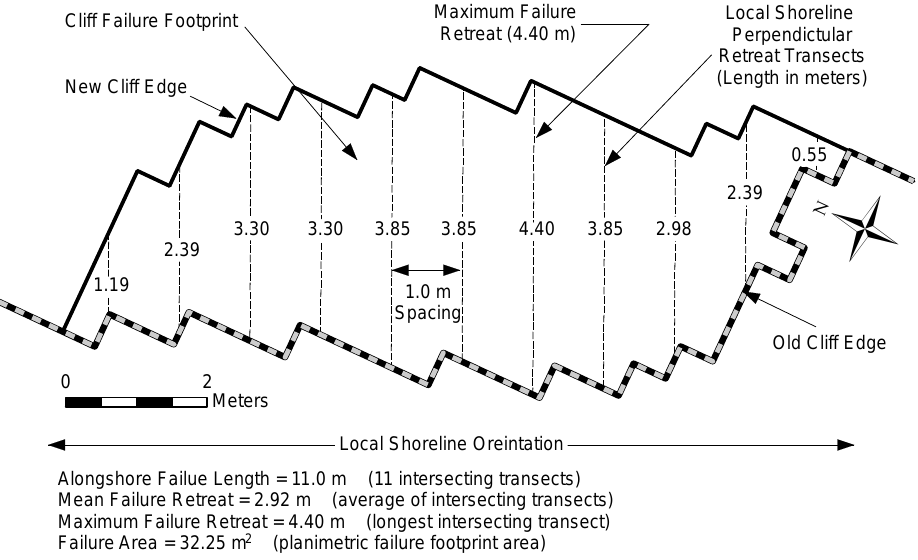
Fig. 5. Example of a cliff failure footprint, local shoreline perpendicular retreat transects, and estimated failure attributes and geometry. Intersecting transects cross the failure footprint, determined on a 0.5m grid. The old cliff edge (thick dashed gray/black line) and new cliff edge (thick solid black line) bound the cliff failure footprint.